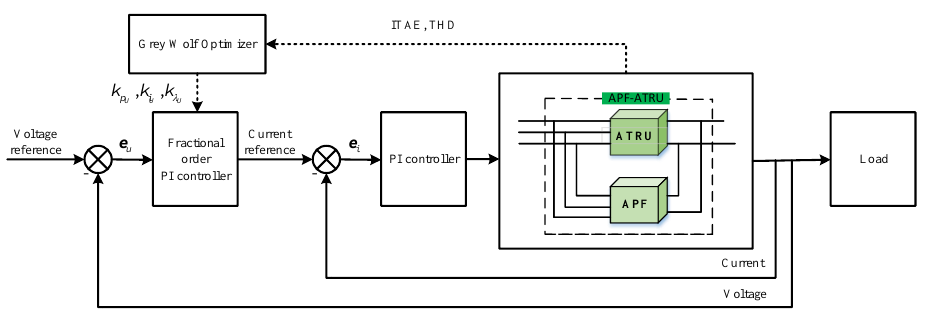
Figure 9. Intelligent control for